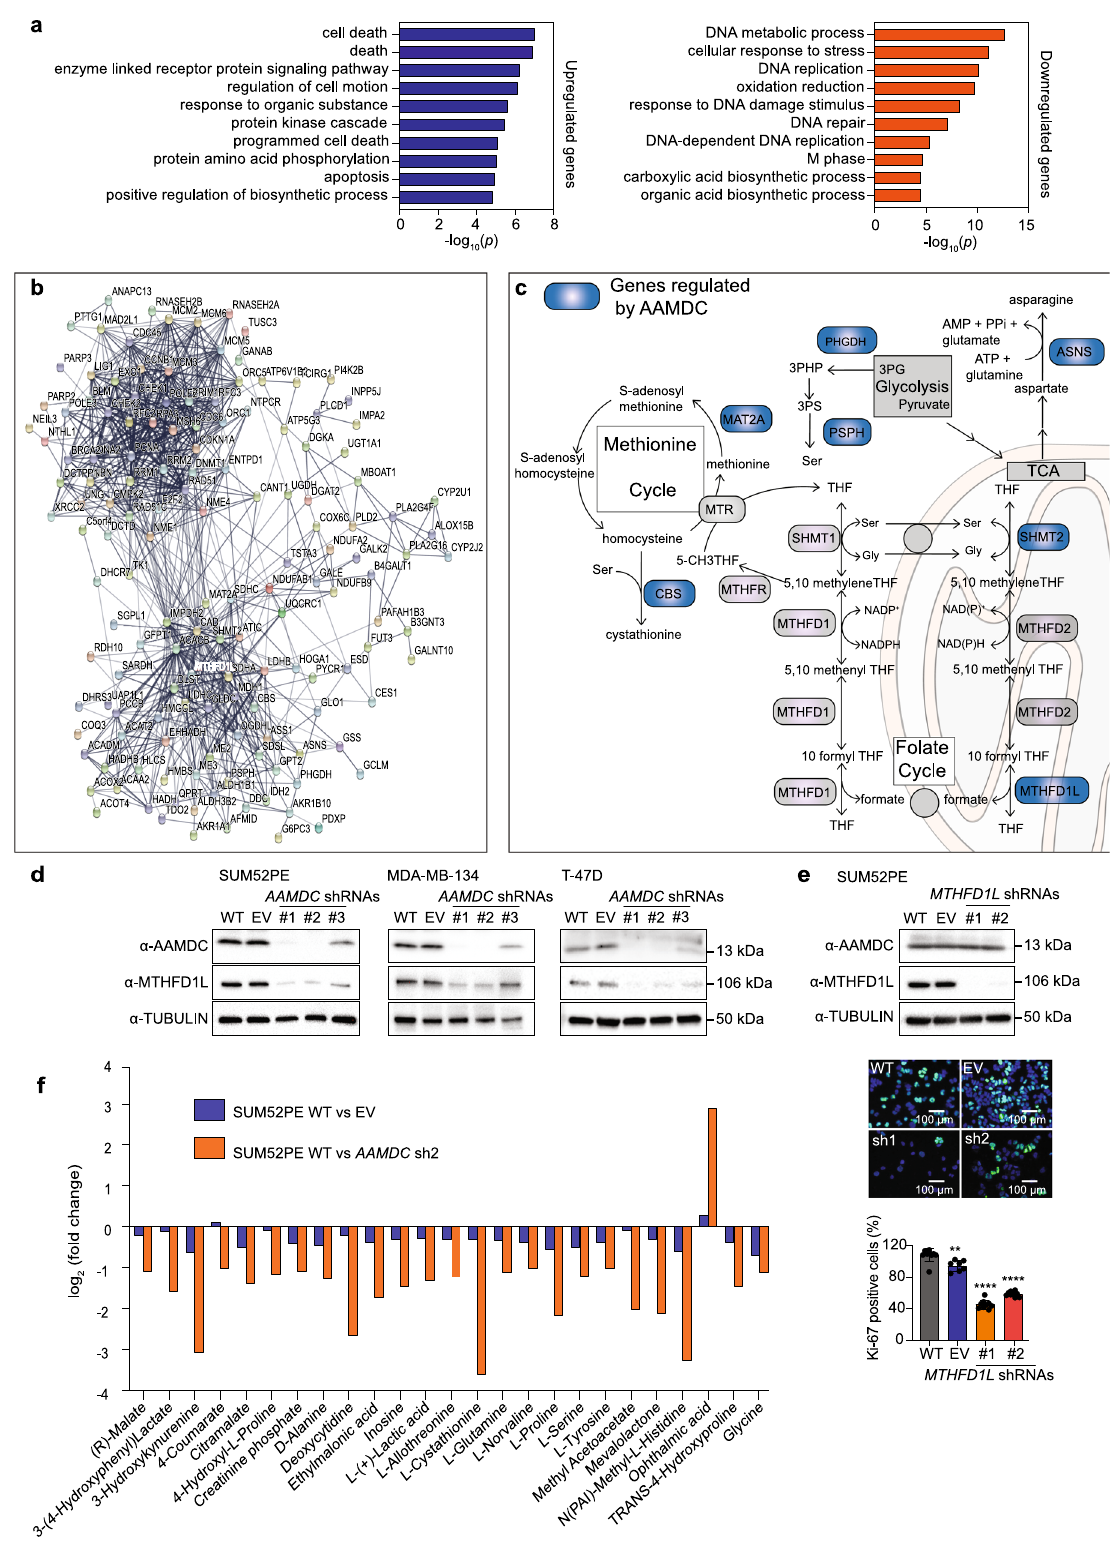
greater in transgenic AAMDC -MCF-7 cells subjected to starva- tion conditions compared to cells grown in complete medium (Fig. 6a, right and 6b, left), thus suggesting the occurrence of post-transcriptional feedback regulatory loops 13 . Overexpression of the AAMDC cDNA in MCF-7 cells also resulted in constitutive AKT activation, particularly in cells depleted of FBS, insulin,